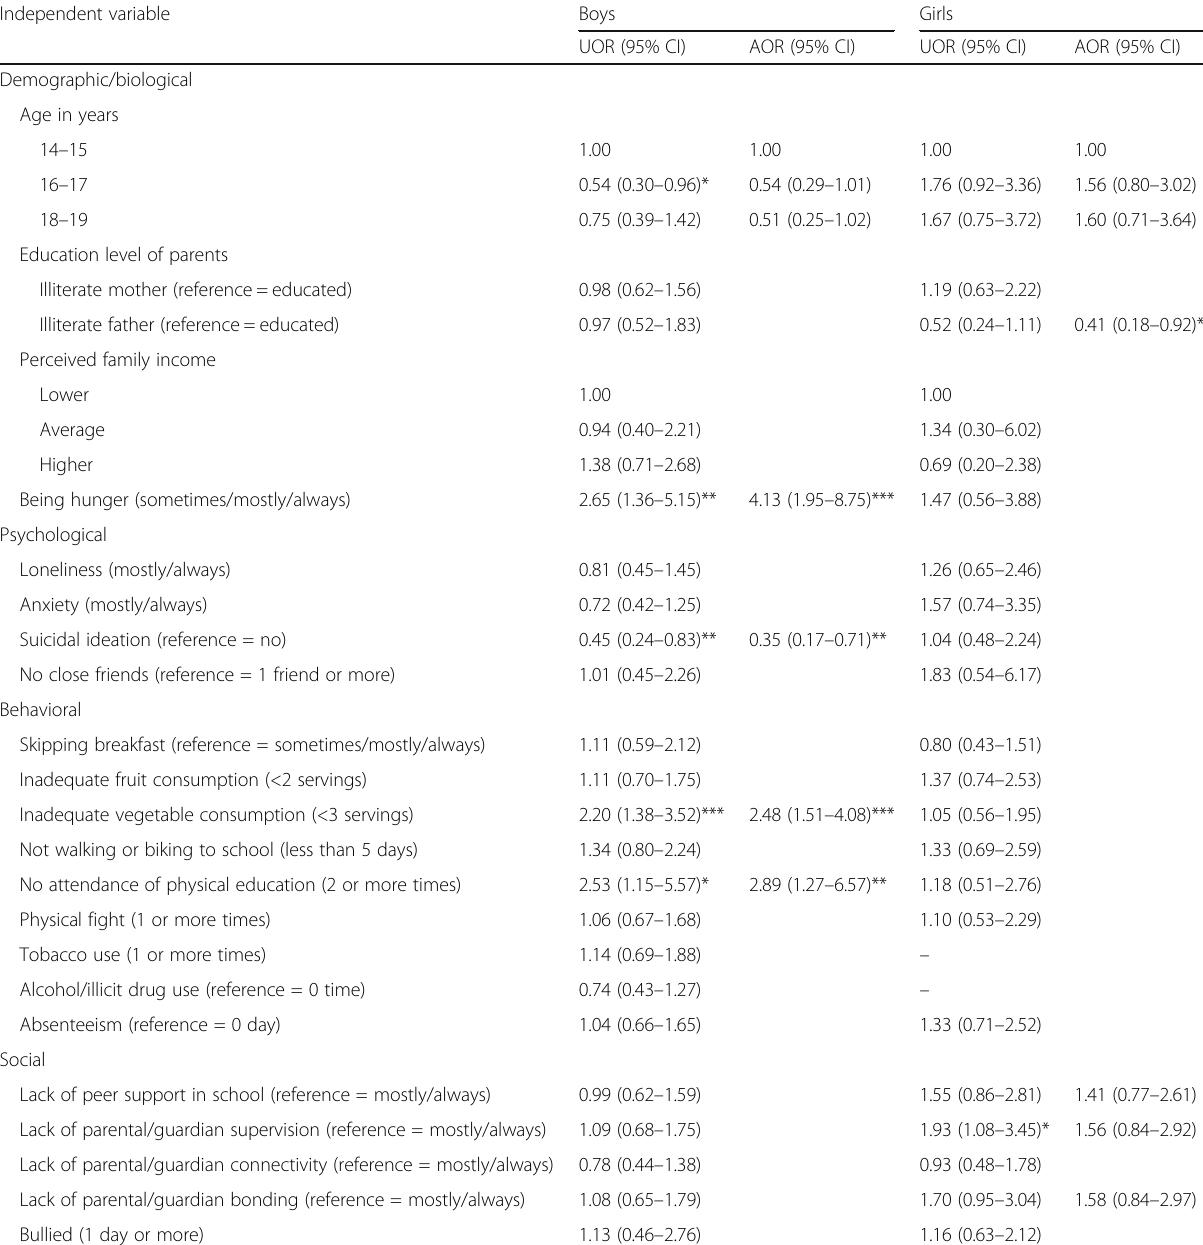
Table 2 Associations between physical inactivity prevalence and independent variables in adolescents by gender Independent